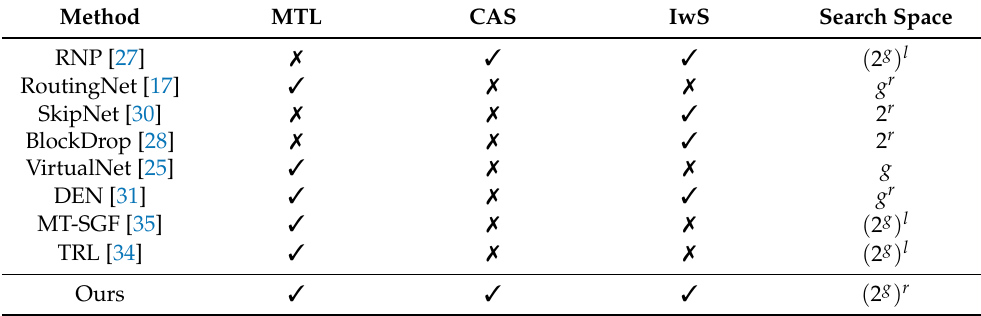
Table 1. Algorithmic comparison of the dynamic search methods with respect to different functionali- ties: multi-task learning (MTL), cost-adaptive search (CAS), and instance-wise search (IwS). Here, g and r are the numbers of groups (or channels) and residual blocks, respectively, and l and e are the numbers of layers and experts in each layer,